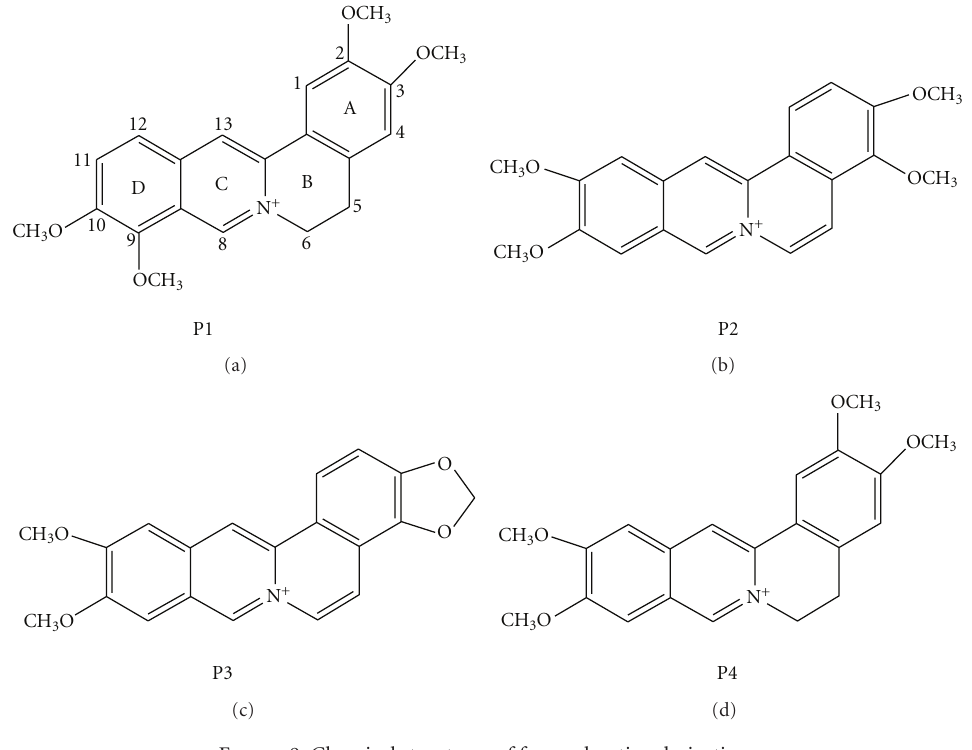
Figure 9: Chemical structures of four palmatine derivatives.